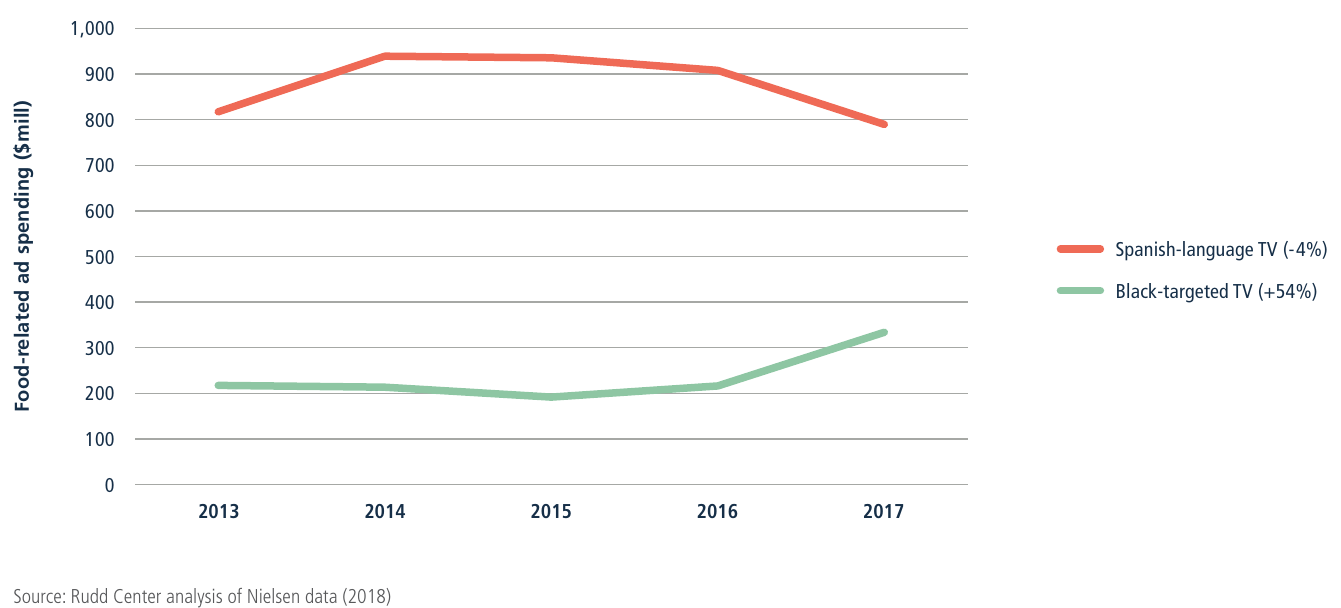
FIGURE 1. CHANGES IN TOTAL FOOD-RELATED ADVERTISING SPENDING ON SPANISH-LANGUAGE AND BLACK-TARGETED